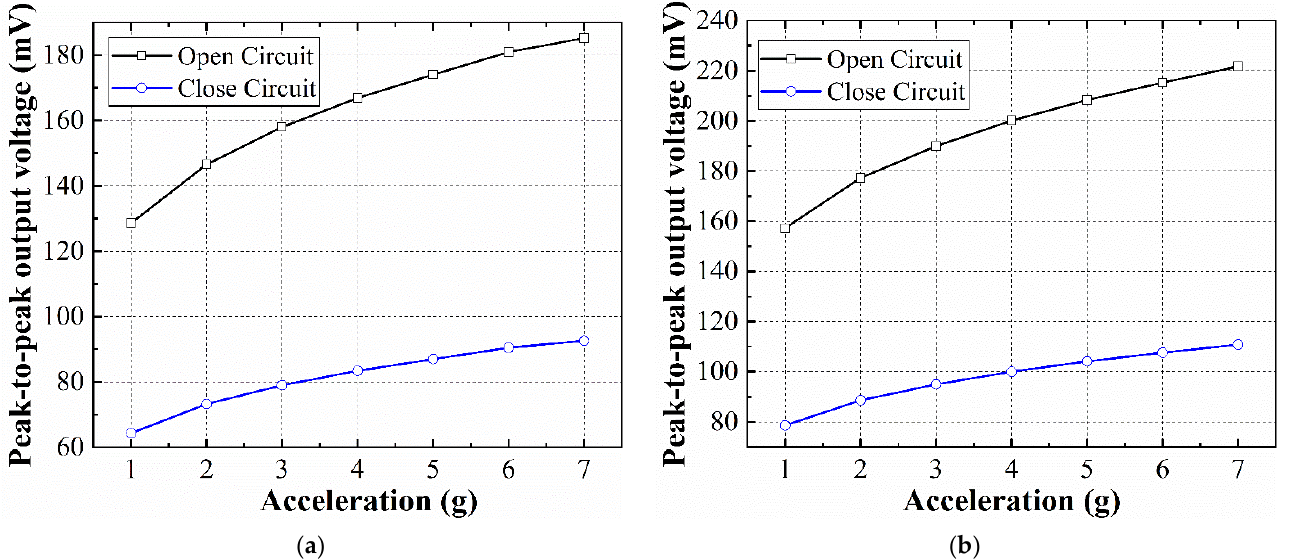
Figure 11. The peak-to-peak output voltage measured in the open circuit and closed circuit at different accelerations: ( a ) T1 device; ( b ) T2 device.